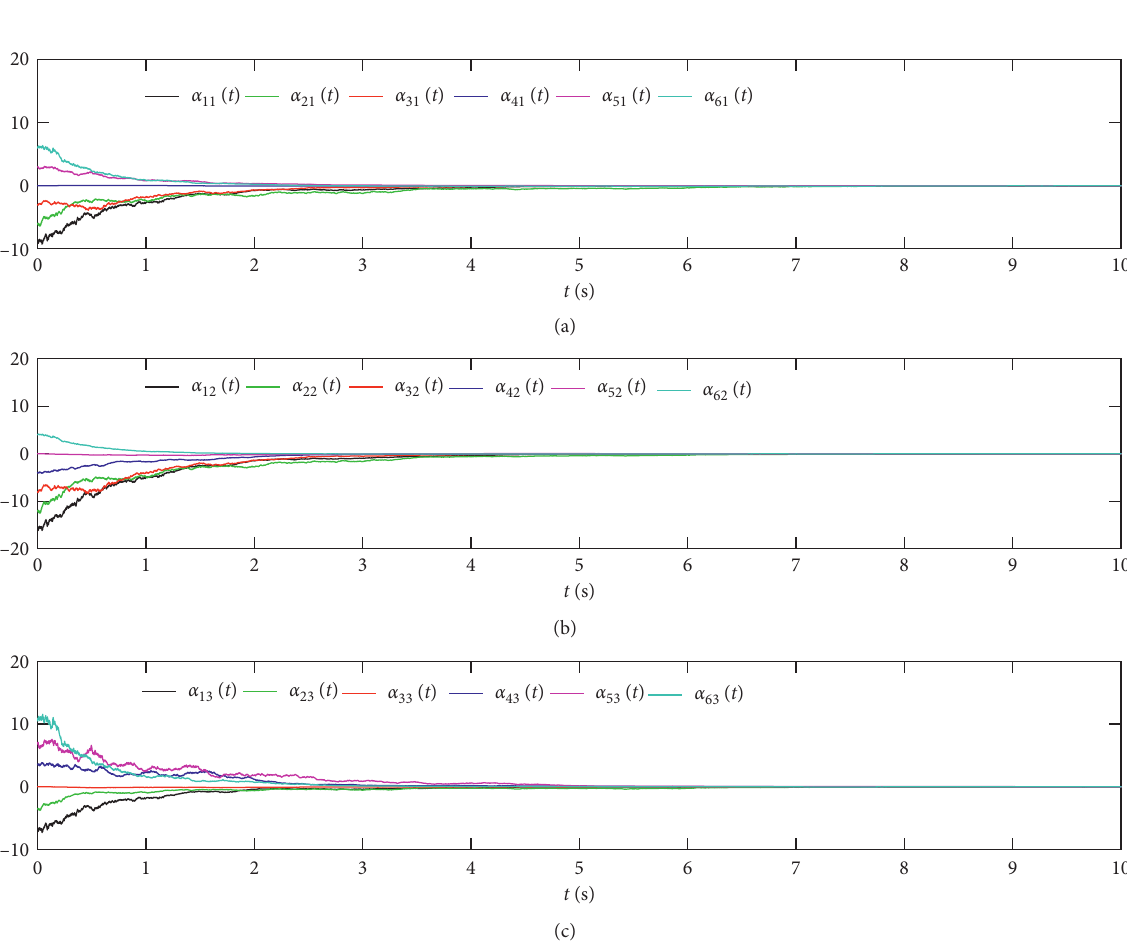
( t ) , α ( t ) , and α z 1 z 2